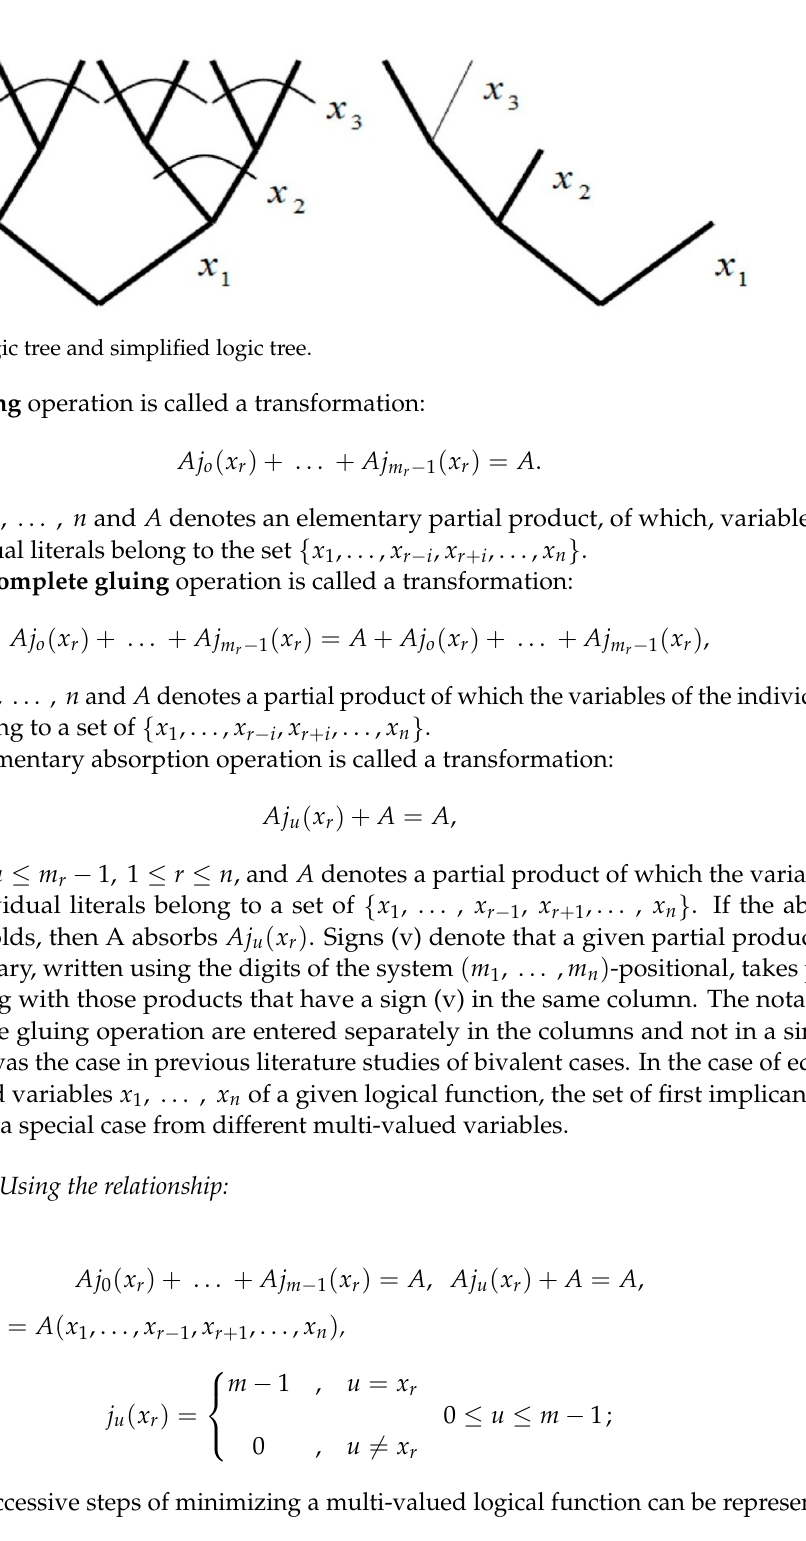
Figure 4. Boolean function of three variables encoded on a logic tree.